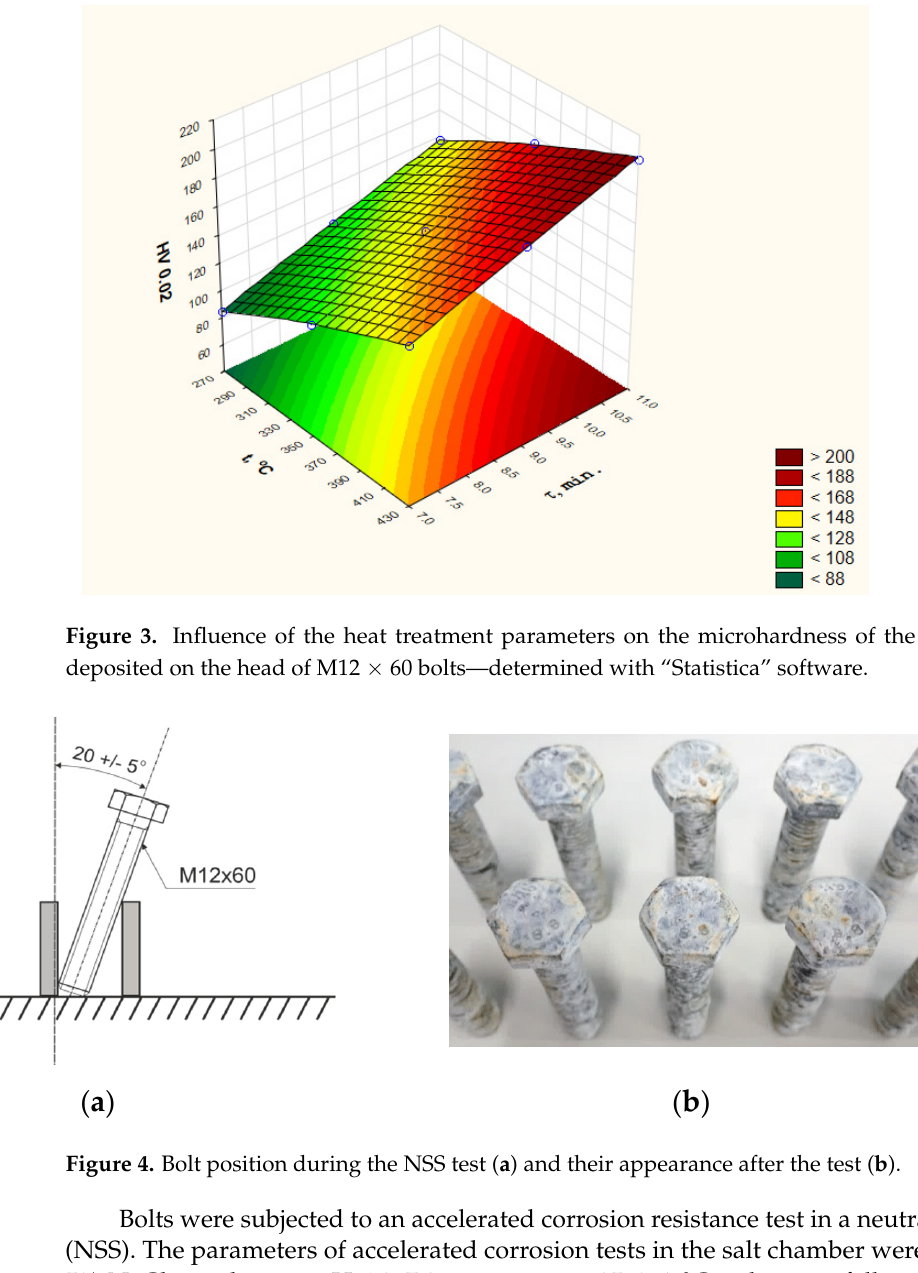
Table 4. Values of the heat treatment parameters and corrosion resistance of zinc coating after HT. Parameter of Heat Treatment